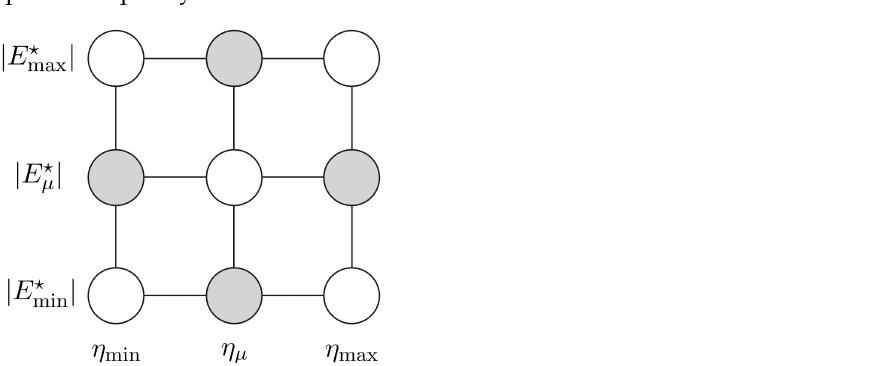
Figure 2. Schematical representation of the bisection estimated values at a specific